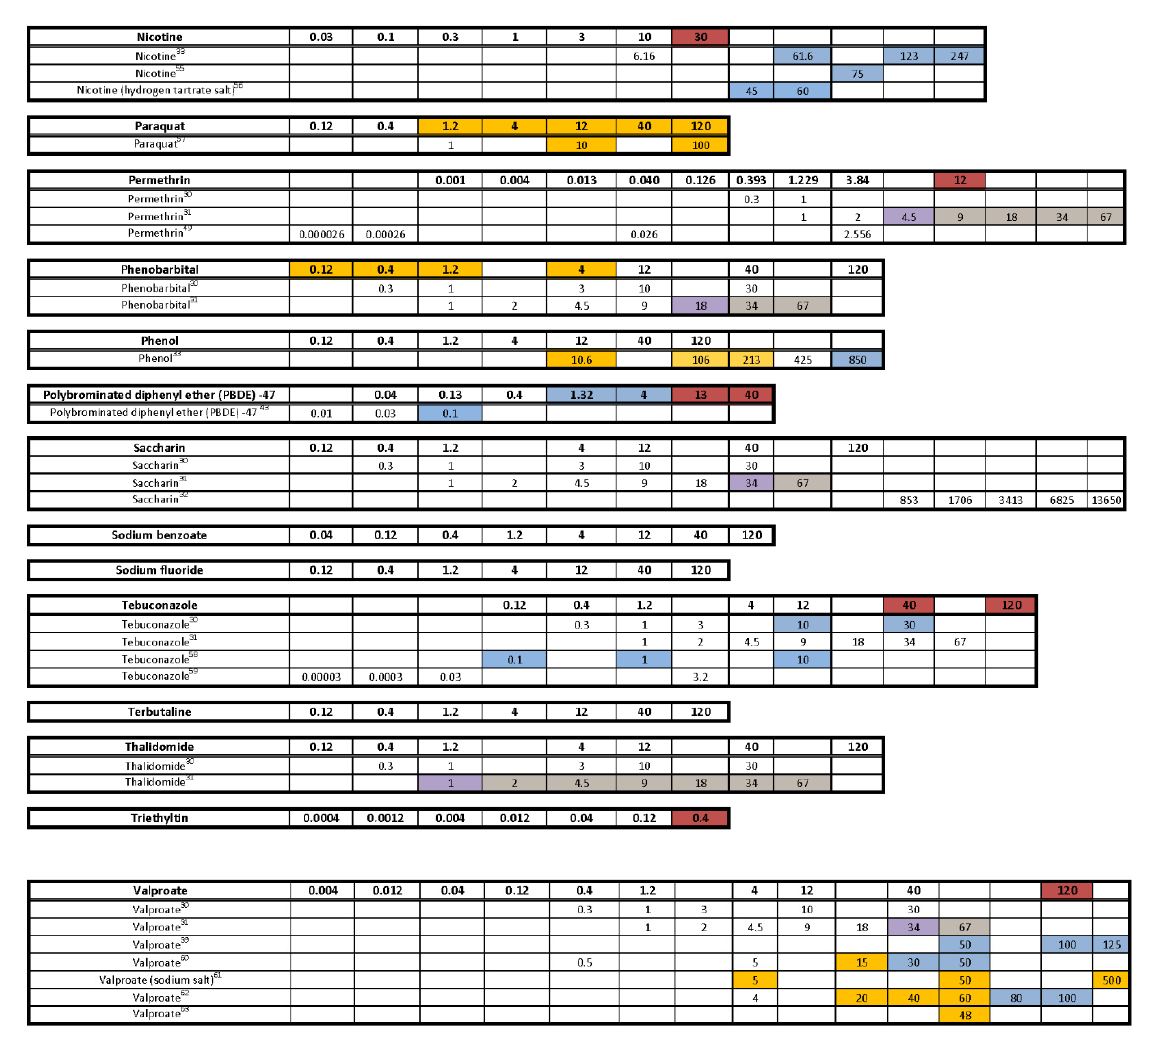
Figure 7. Comparison of the Present Behavioral Results with Previous Studies from the Literature that Included Similar Experimental Conditions Testing the Same Chemicals. To be included, all studies met the following criteria: chemical exposure began during 0–3 dpf and lasted at least 24 h; behavior was tested 5–7 dpf, included an acclimation period prior to testing and at least one transition from Light to Dark during the testing protocol. This figure was populated based on information reported by other researchers; the results were not interpreted or inferred. Some studies only reported the lowest effect dose and did not report results for other concentrations that may also have had an effect. Effects may have occurred in the acclimation, Light or Dark periods. Colored shading represents the following: blue = decrease in activity; yellow = increase in activity; blue with yellow center = both decrease and increase in activity; purple = direction of the effect could not be determined; gray = chemical concentration was tested, but results were unclear and effect could not be determined; red = developmental toxicity for the current study only. Superscript refers to publication number in the reference section of this manuscript. The results for the current study are on the first line for each chemical, with bold text. Chlorpyrifos was both a test chemical and a positive control in our study; the results for the positive control are indicated by the (+) in this figure. All concentrations are in micromolar ( μ M).